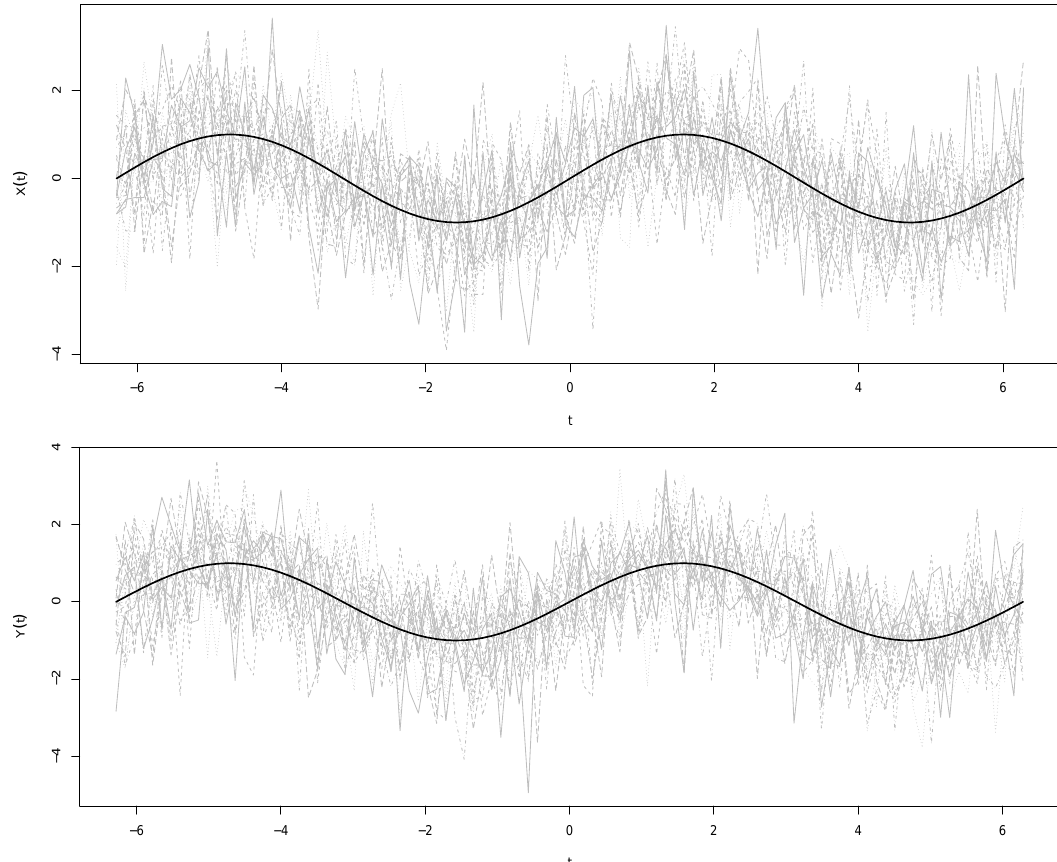
Figure 1. Curves simulated (gray lines) under the null hypothesis a ( t ) = 0 ( t ) in group 1 ( at the top ) and group 2 ( at the bottom ). The black lines in both cases correspond to the mean curve µ ( t ) = sin ( t )